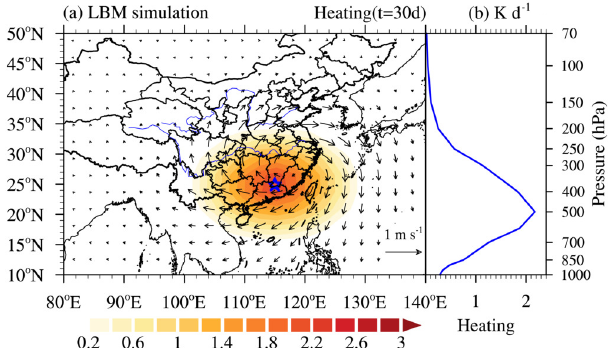
Figure 9. (a) Heat forcing at 500hPa (shading, unit: Kd − 1 ) and the steady response of wind at 300hPa (vectors, unit: ms − 1 ) and (b) profile of the heat forcing at the location marked by the blue star in Fig. 9a.